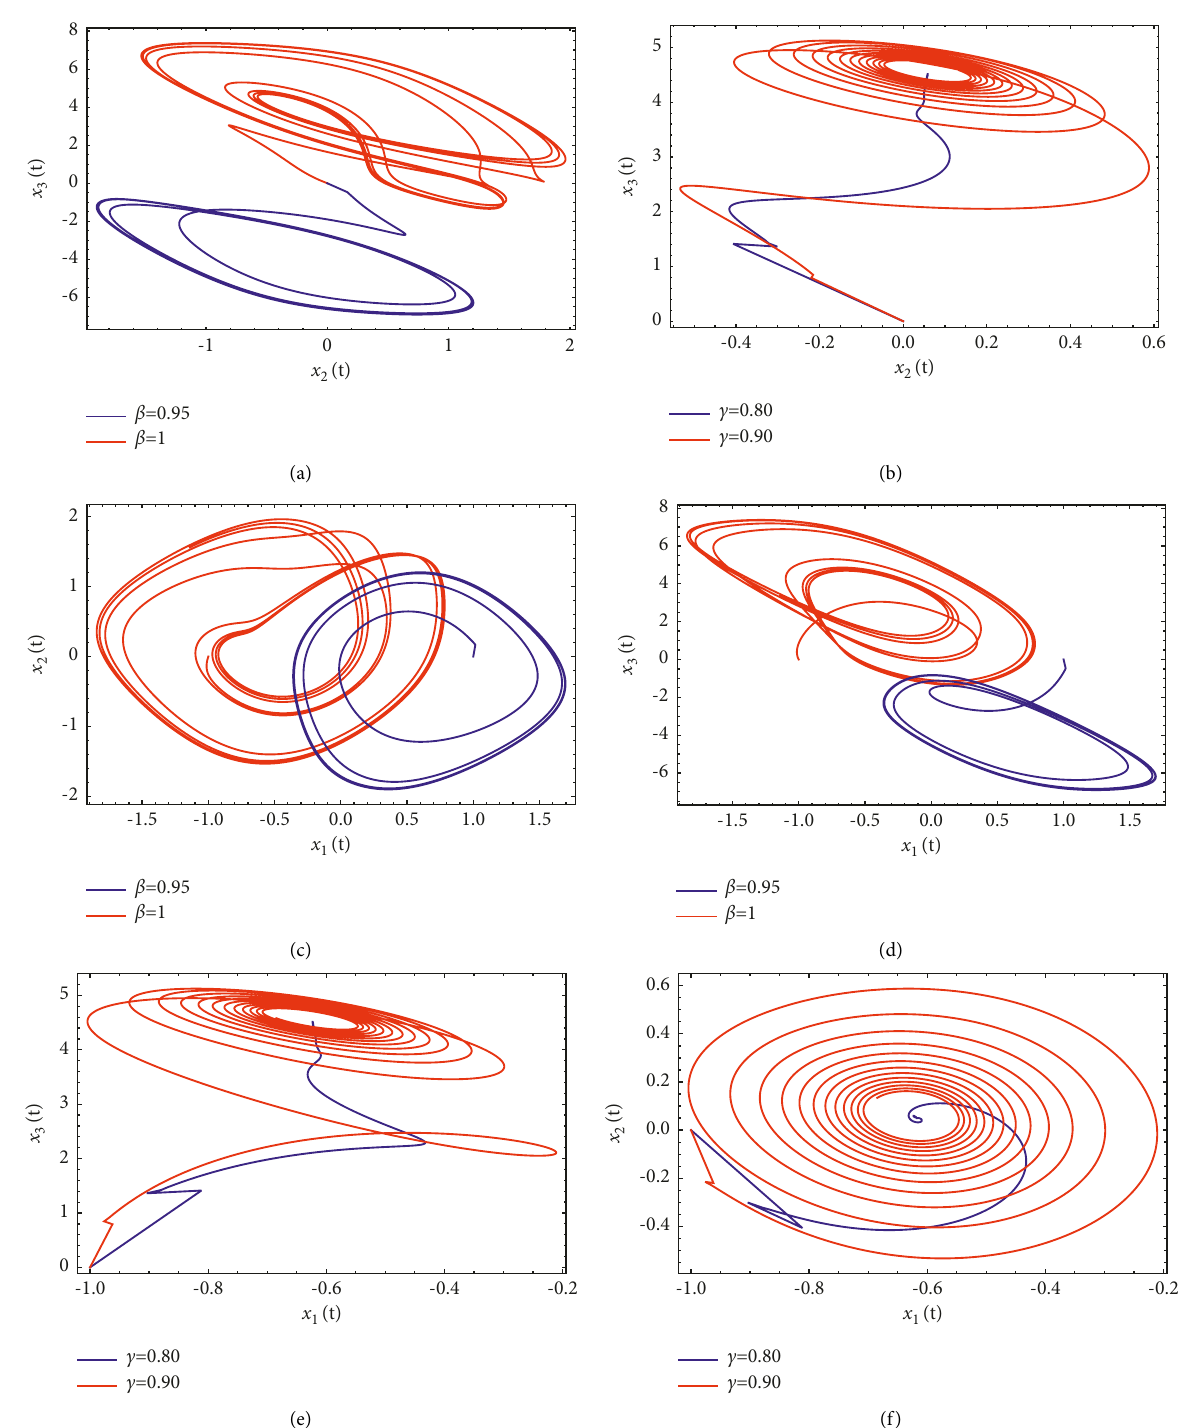
Figure 2: Dynamics of coexisting multiple attractors’ for gradient β (a) State variables x 2 versus x 3 ; (b) state variables x 2 versus x 3 ; (c) state variables x 1 versus x 2 ; (d) state variables x 1 versus x 3 ; (e) state variables x 1 versus x 2 ; (f) state variables x 1 versus x 3